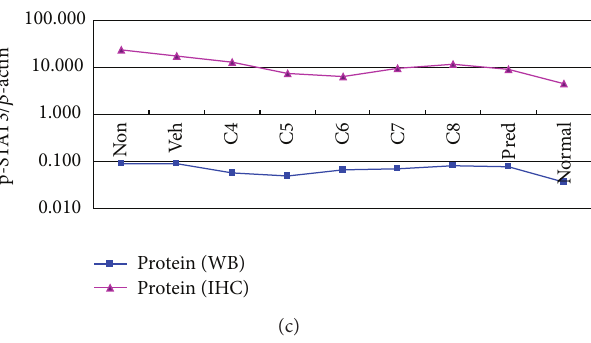
Figure 6: Lactobacillus acidophilus treatment attenuated the phosphorylation level of STAT3 (p-STAT3) in colitis. The expression level of p-STAT3 was determined by both Western blotting (WB, (a)) and immunohistochemistry (IHC, (b)) in the colonic tissues of normal control mice group (normal) and DSS-induced model mice groups, including L. acidophilus -treated C4–C8 groups, prednisone acetate treated positive control (Pred), and nontreated (Non) and vehicle (Veh) treated control groups. Representative images of Western blotting and immunohistochemical staining showing subcellular localization of p-STAT3 in the colon of nontreated model control mice are shown on the left, and a bar graph representing mean ± SD ( 𝑛 = 8 ) values is shown on the right. A plotted trendline chart shows p-STAT3 expression in each group as determined by WB and IHC (c). a 𝑃 < 0.05 versus Non, b 𝑃 < 0.05 versus Veh, c 𝑃 < 0.05 versus Pred, and d 𝑃 < 0.05 versus